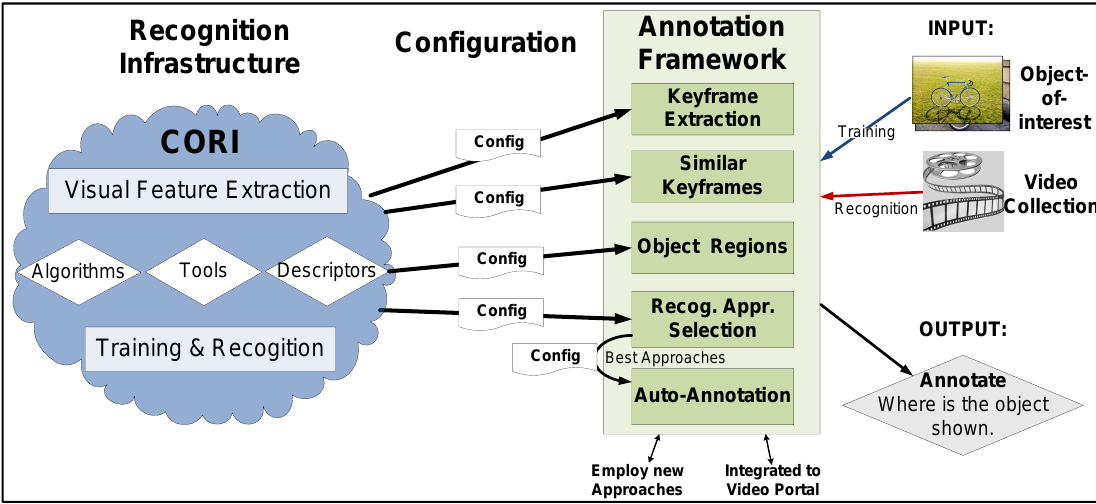
Figure 5. Overview of the recognition infrastructure in the annotation